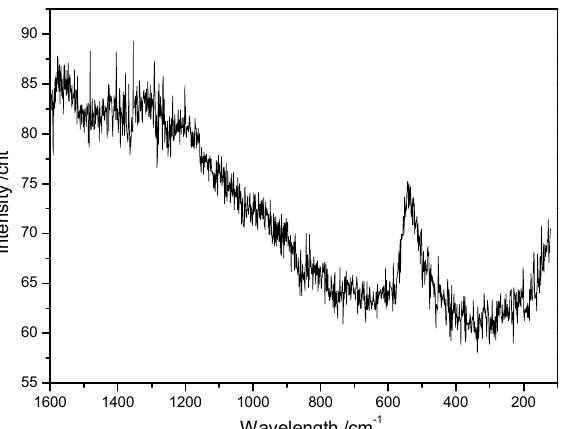
Figure 5. Raman spectrum of siderazot applying a green laser at 532 nm. No background correction, unoriented sample.